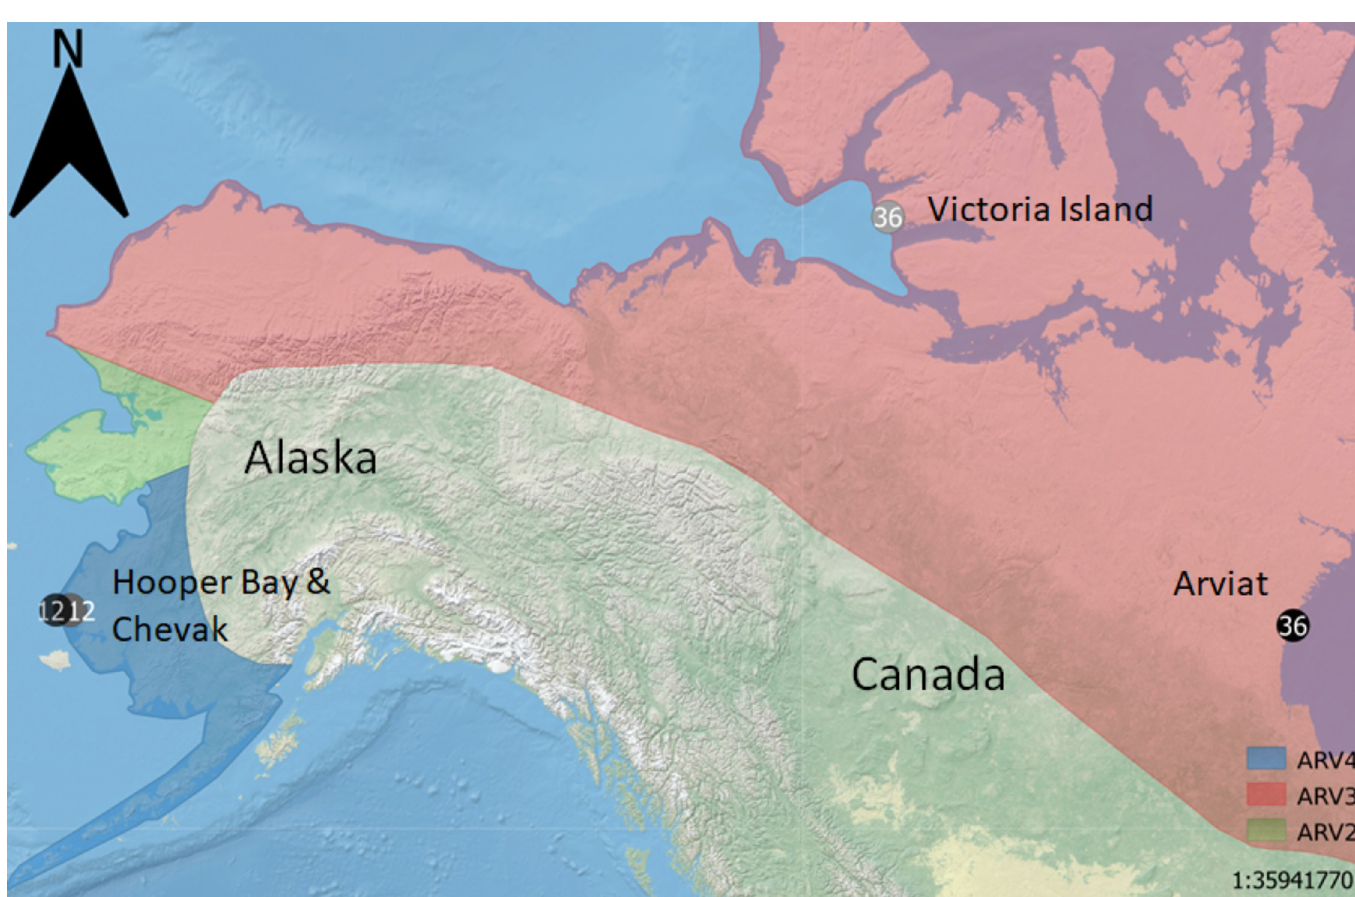
Fig 1. Approximate arctic rabies variant distributions in North America and schematic of the 96 arctic fox samples used in the genotype-by-sequencing assay. Circles indicate sample locations; numbers within circles indicate sample size. Samples were obtained from Arviat, NU (n = 36); Victoria Island, NWT (n = 36); and two regions of Southwest Alaska, (Chevak (n = 12) and Hooper Bay (n = 12). Approximate arctic rabies viral variant distributions (ARV 2,3,4) are depicted by colored regions (see in-figure legend). The schematic of viral variant distributions was adapted from Goldsmith et al., 2016 [31] for illustrative purposes only. Map created using Natural Earth